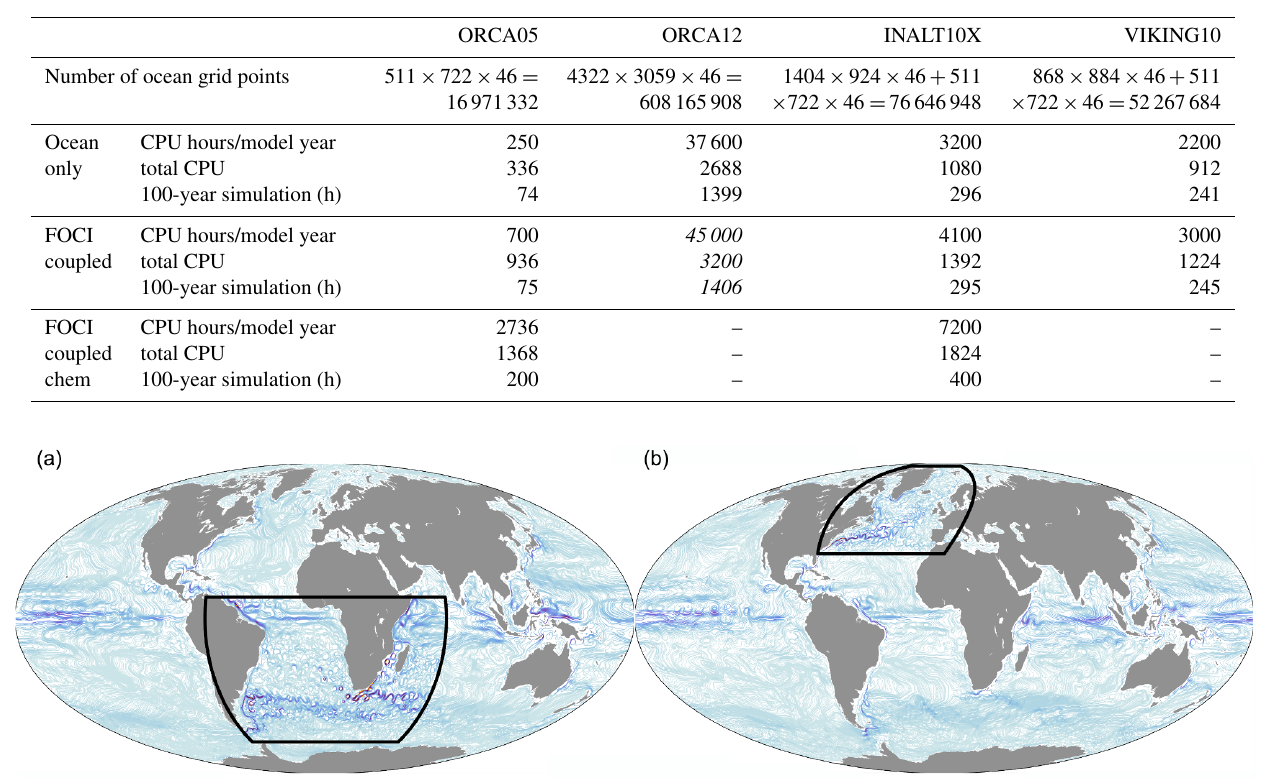
Table 1. High-performance computing resources for various configurations of the FOCI model system. These values are based on a Cray XC30 machine at the Zuse Institute Berlin (ZIB), part of the North-German Supercomputing Alliance (HLRN), and estimates of non-existing configurations in italic. All coupled experiments use a T63L95 atmosphere resolution. The total number of ocean grid points is depicted in the first row for two global (ORCA05 1 / 2 ◦ , ORCA12 1 / 12 ◦ ) and two nested configurations at 1 / 10 ◦ in a 1 / 2 ◦ host grid (IN- ALT10X and VIKING10). Rows 2 to 4 specify resources for uncoupled experiments and coupled experiments without and with atmospheric chemistry, respectively, for all resolutions.